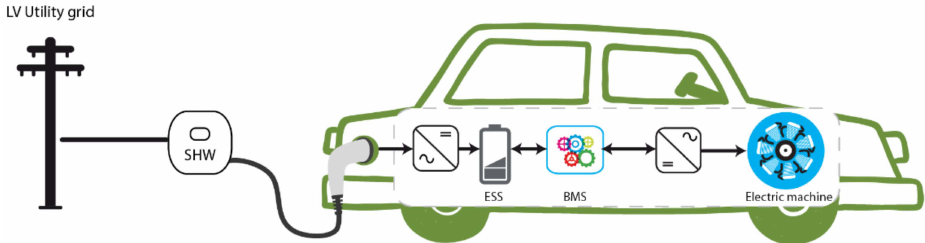
Figure 1. EV mechanical